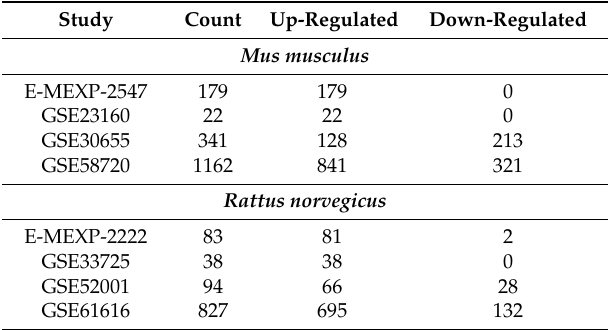
Table 5. Summary of differential expression analysis in each study.